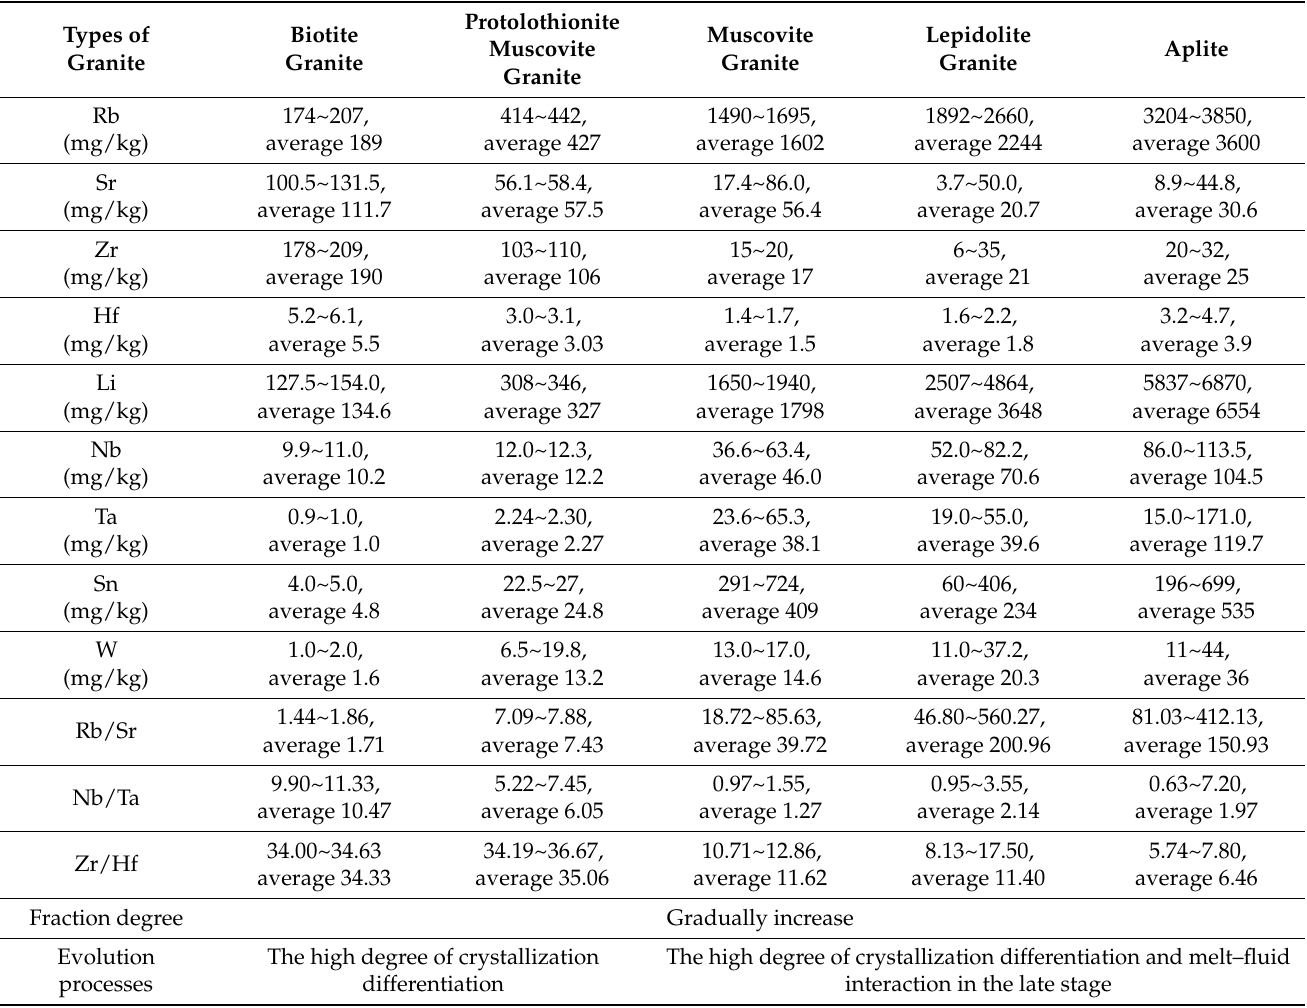
Table 3. Comparison of characteristics of different types of granite in the Ganfang